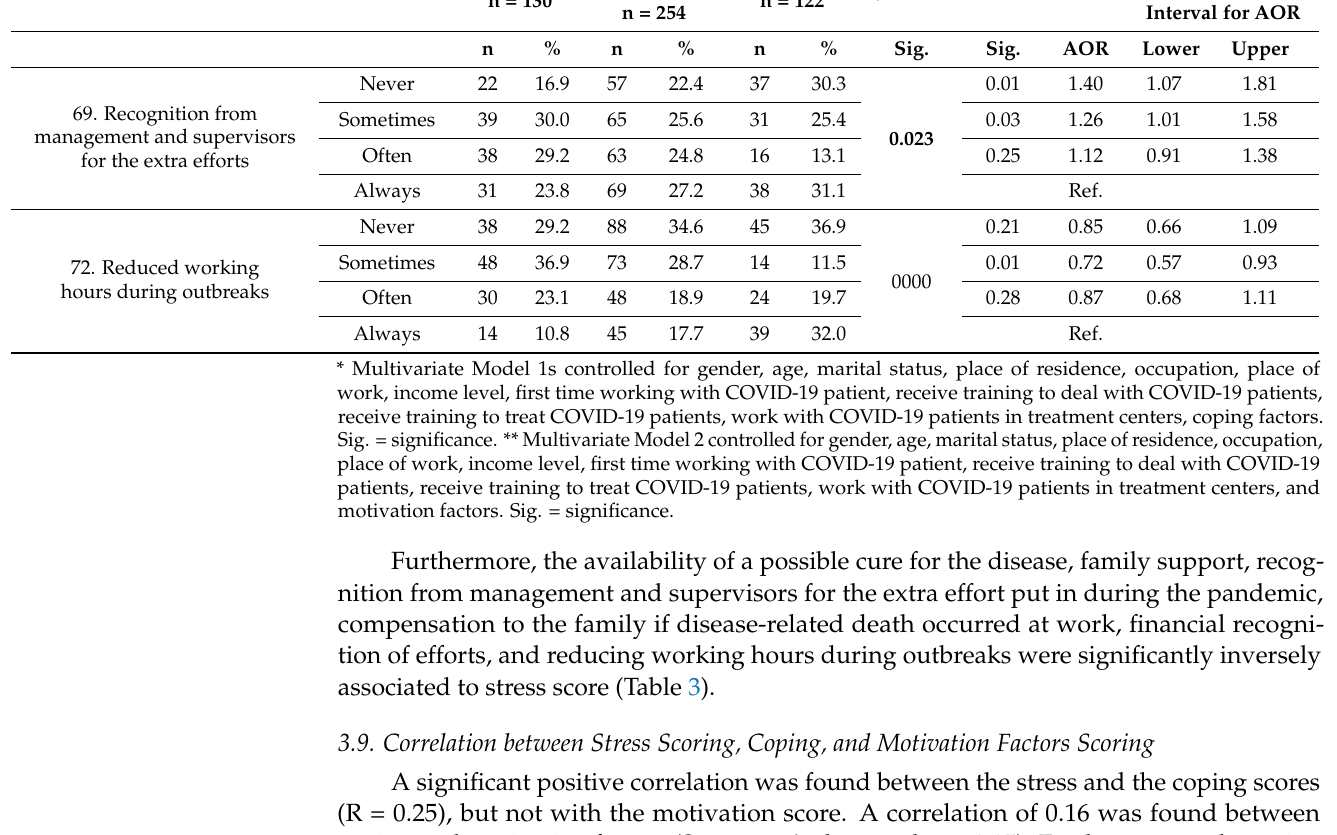
Table 4. Correlation between stress scoring, coping scoring, and motivation scoring, and their association with the stress index (N = 506). Correlation Coefficient Adjusted Analysis * with Stress Scoring with Stress Index Spearman’s Significance rho